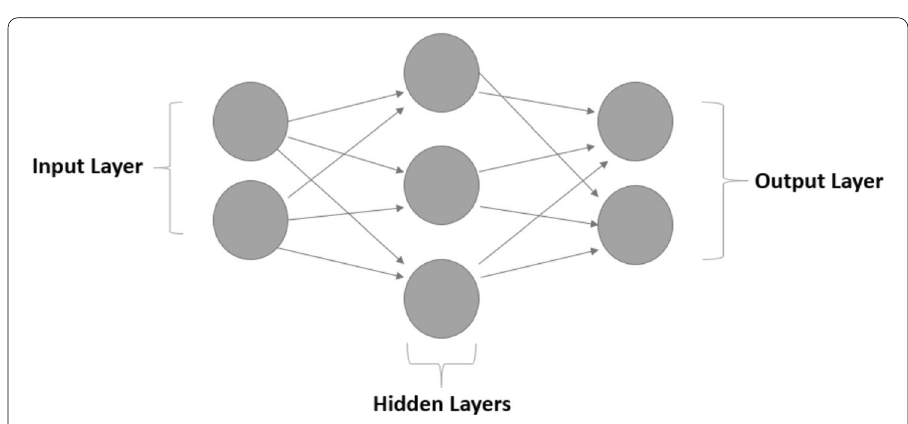
Fig. 1 MLP Algorithm